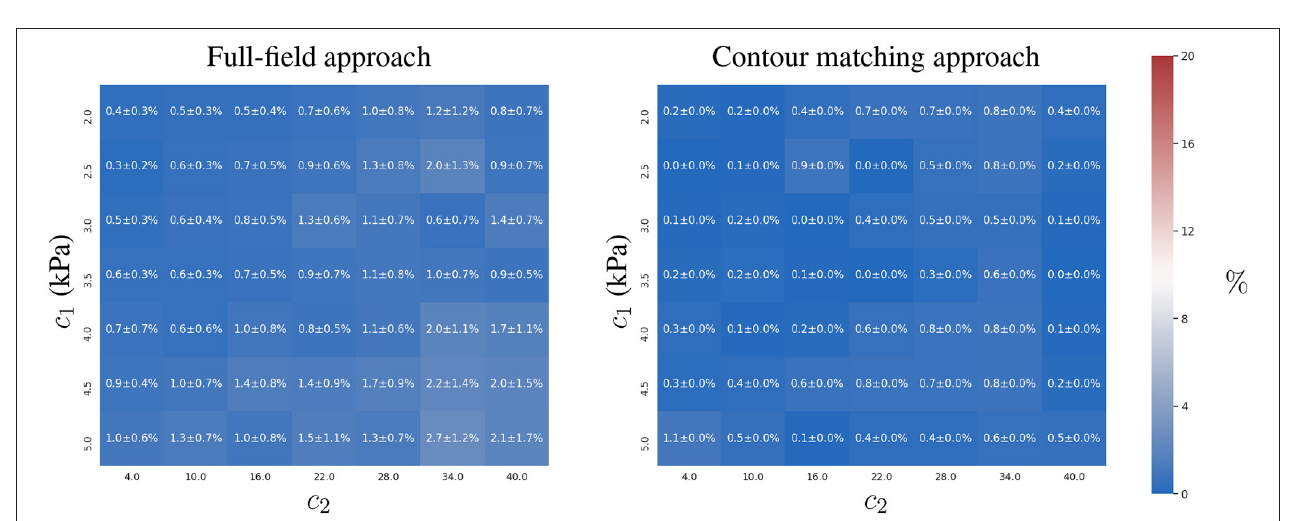
FIGURE 6 | Relative error in estimating intra-ventricular pressure p using full-field tracking and contour matching approaches with a load of p = 0.9 kPa in the absence of noise in the observations. For details of the estimation of other loads, refer to the Supplementary Material .